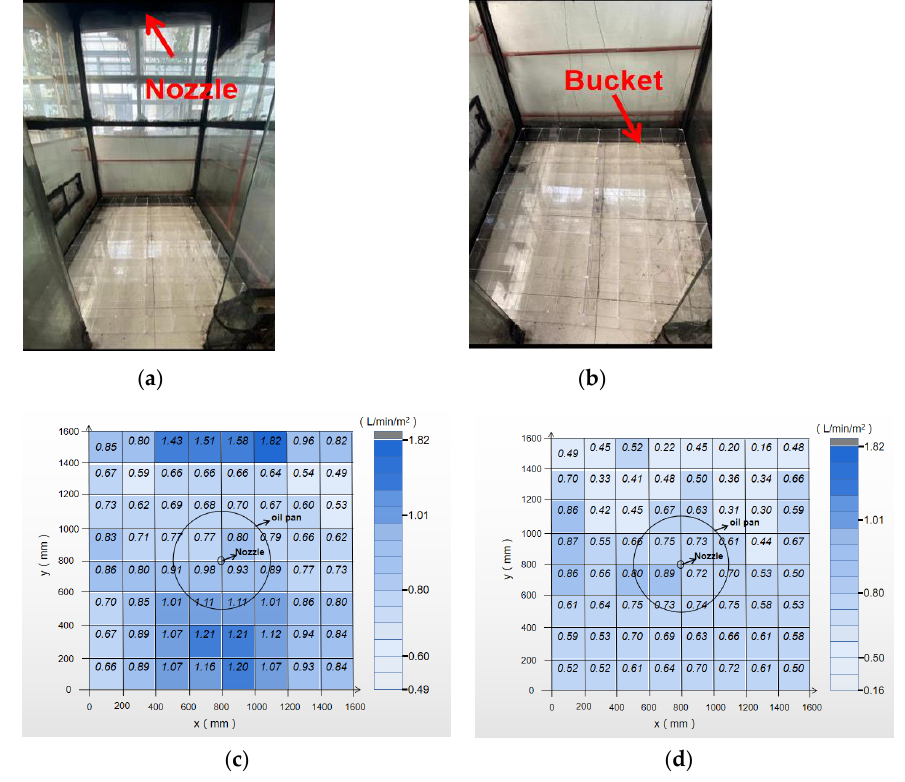
Figure 5. The measured front view ( a ) and top view ( b ), and the measured water flux density distribution of hot ( c ) and cold water ( d ). Table 1. Particle size distribution of cold and hot water mist under various pressures.